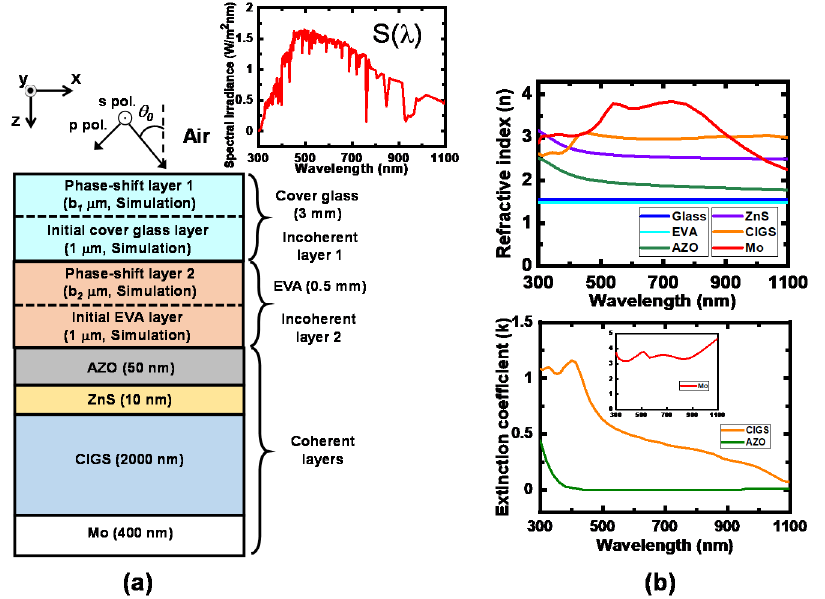
Figure 2. ( a ) Schematic diagram of the planar CIGS solar cell together with the spectral irradiance of the AM 1.5 sunlight ranging between 300 and 1100 nm. Both the 3 mm cover glass and 0.5 mm EVA layers, the thicknesses of which are greater than the coherence length of sunlight (~0.6 μ m), are treated as incoherent. The remaining layers are considered as coherent. Because the glass cover and the EVA flattening layers are assumed to be transparent, both layers are modeled as the 1 μ m thick initial layer plus the respective phase-shift layer whose thicknesses b 1 and b 2 are determined based on Eq. (4) when the ADETAM is applied to calculate the effect of the incoherent front glass and EVA layers in the simulation. ( b ) Complex refractive index spectra of the materials used in the CIGS solar cell.